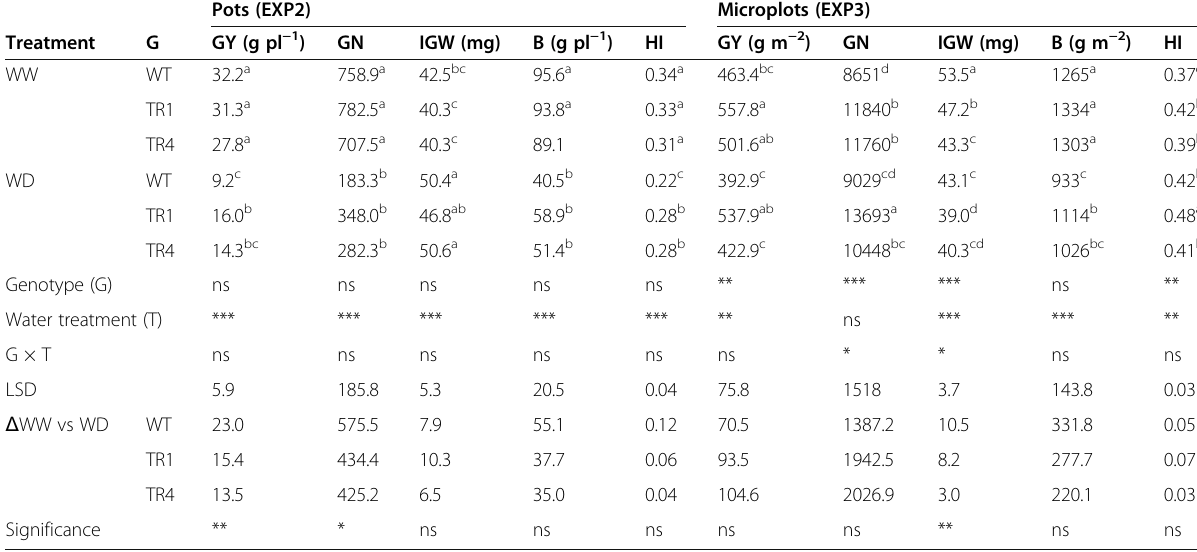
Table 2 Grain yield and its primary and physiological components for the genotypes grown under greenhouse conditions Pots (EXP2)